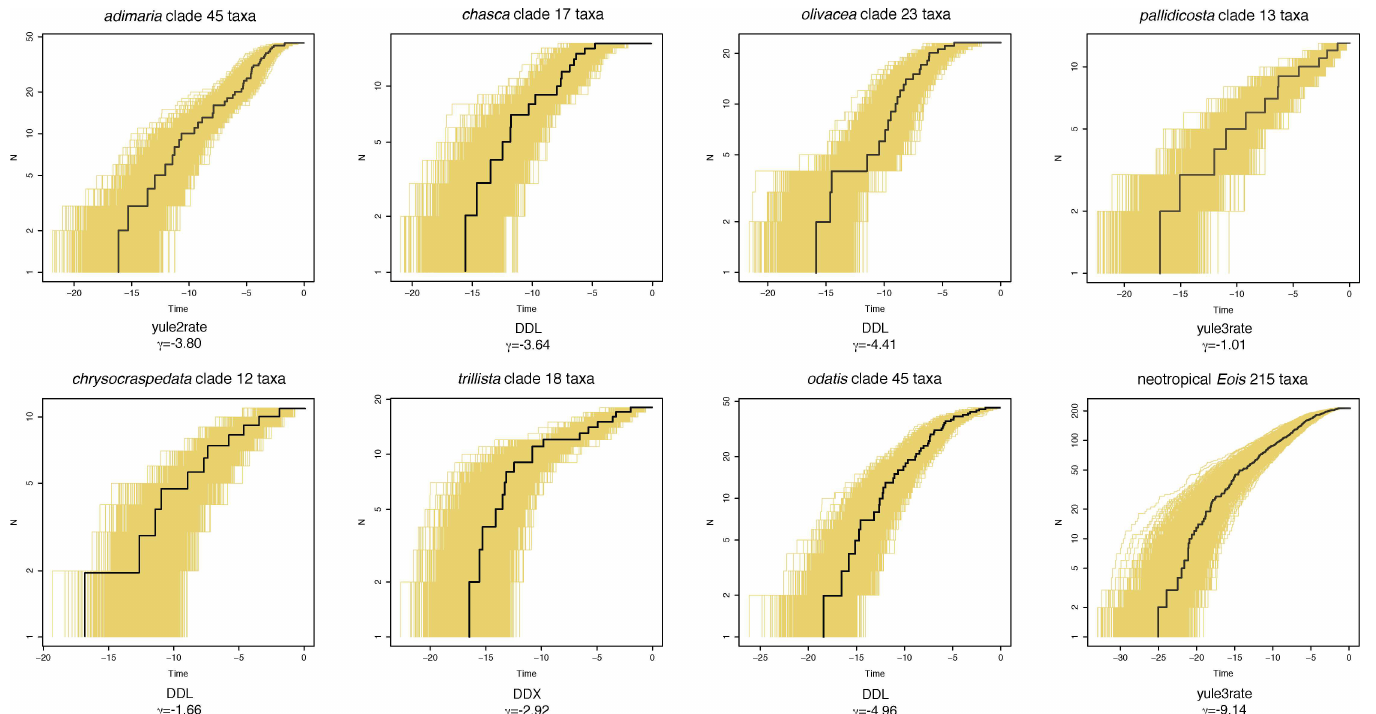
Fig 6. Lineage through time plots. Lineage through time plots for Neotropical Eois and for all internal clades containing at least 10 species are presented. The entire BEAST tree sample was plotted for each clade, with the plot resulting from the maximum clade credibility tree superimposed (black). Below each chart the respective best evolutionary model and the value of the pertinent gamma statistics are